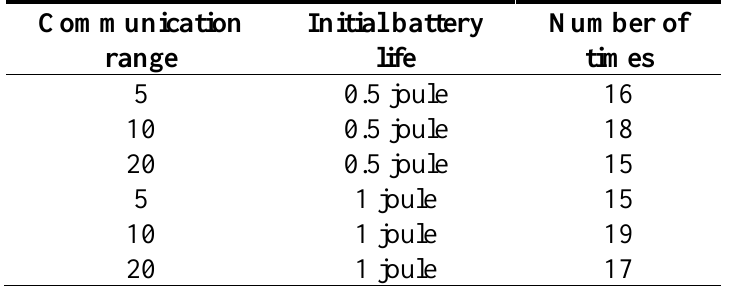
Table 1. The number of times of different network